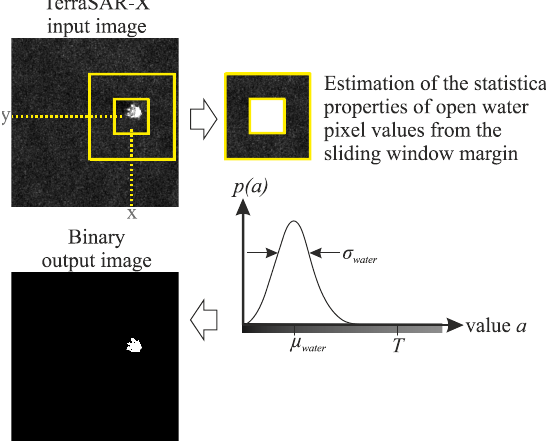
Figure 2. Basic principle of the CFAR detector